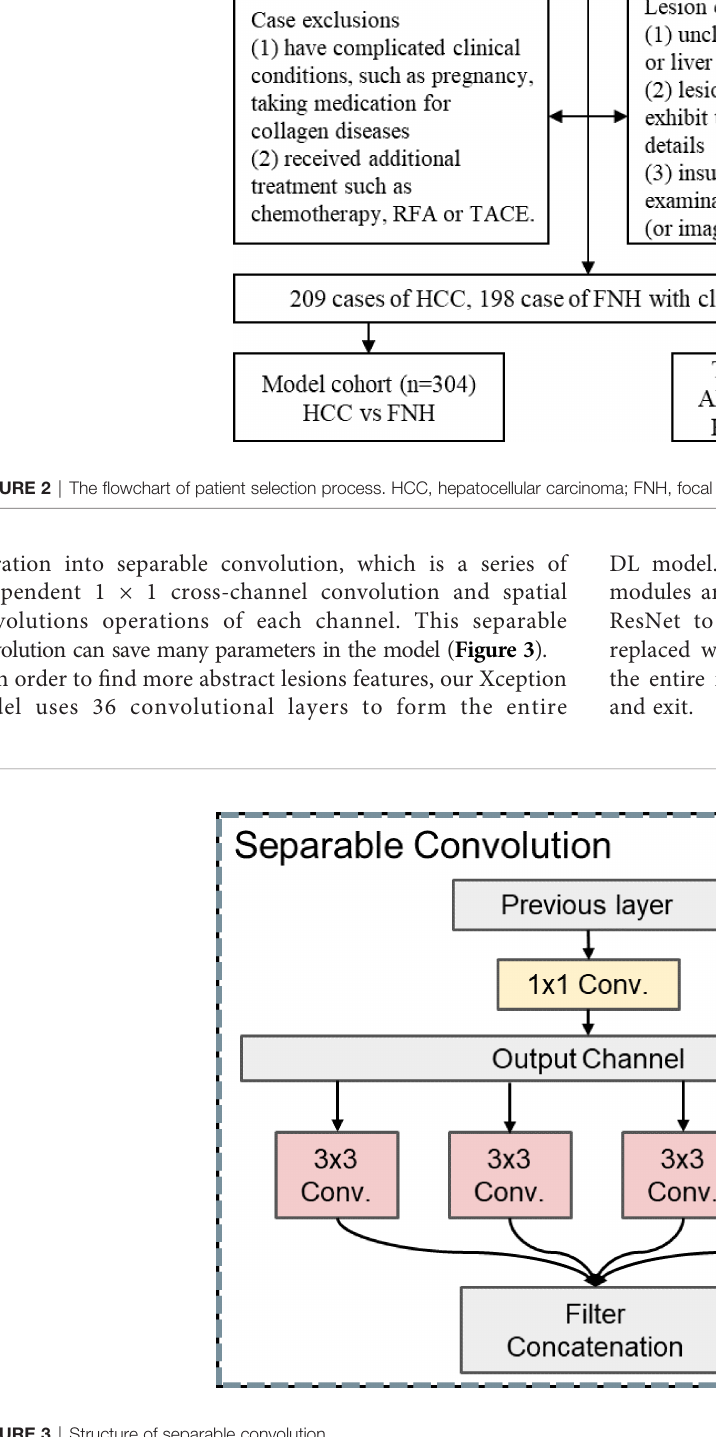
FIGURE 3 | Structure of separable